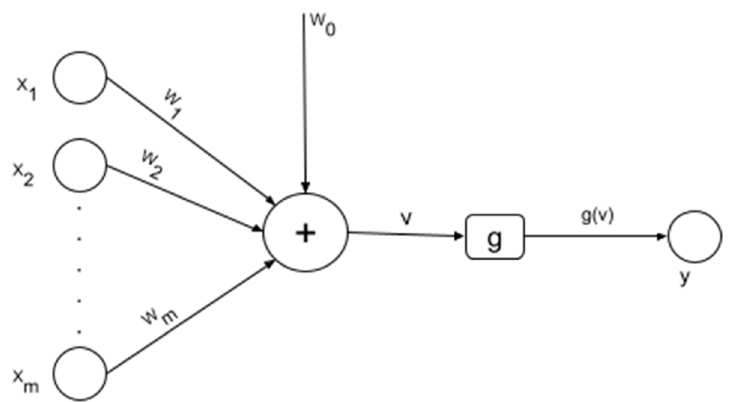
Figure 3. Artificial neuron.